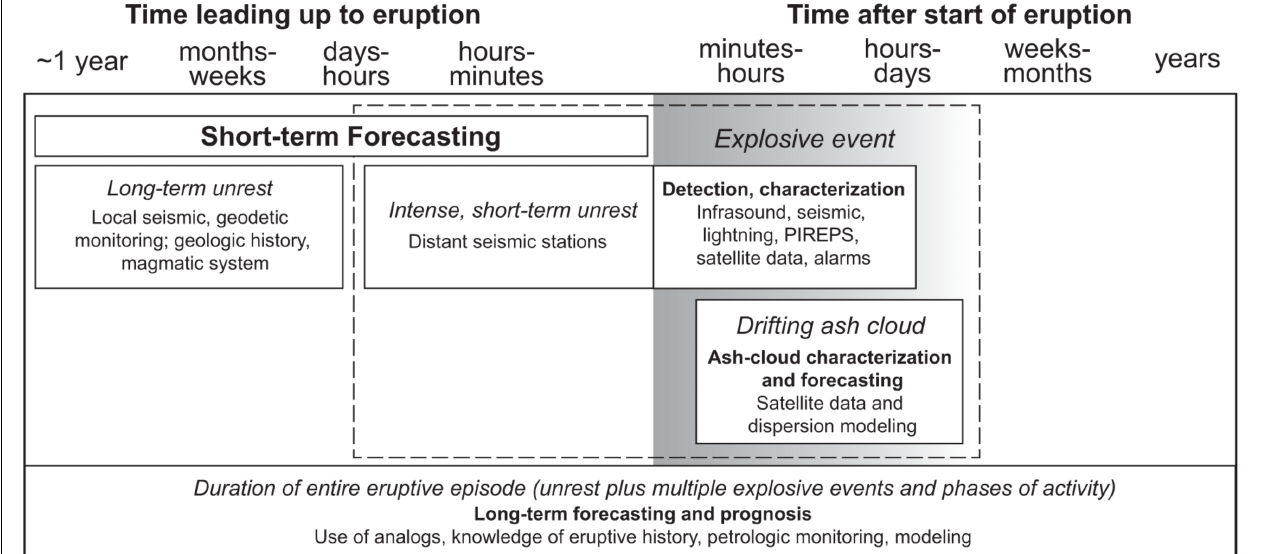
FIGURE 3 | Generalized timeline illustrating different components of short-term volcano forecasting. In this paper, we focus on the events that occur within the hours and minutes just prior to and after the onset of an explosive event (dashed box): very short-term eruption forecasting, event detection, and event and ash-cloud